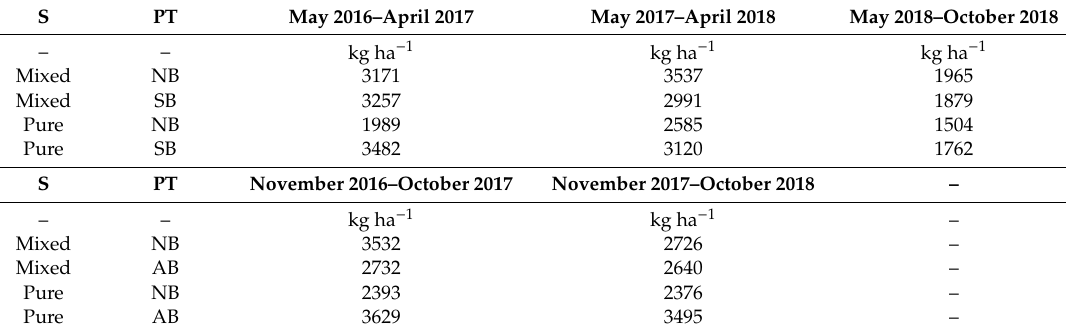
Table 5. Litterfall collected in mixed and pure stands per